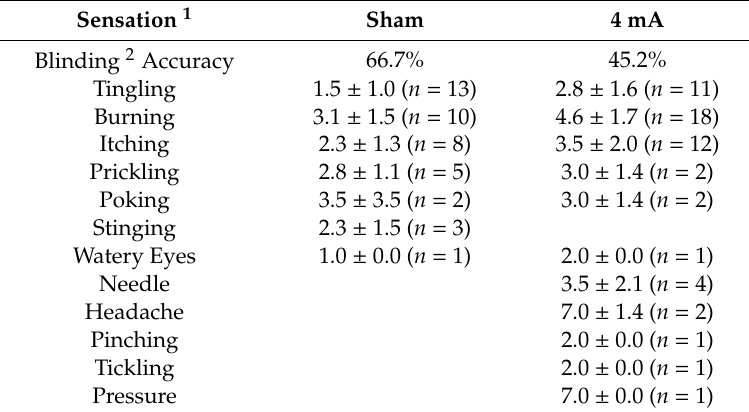
Table 1. Blinding and tolerability results for sham and 4 mA tDCS ( n = 31).